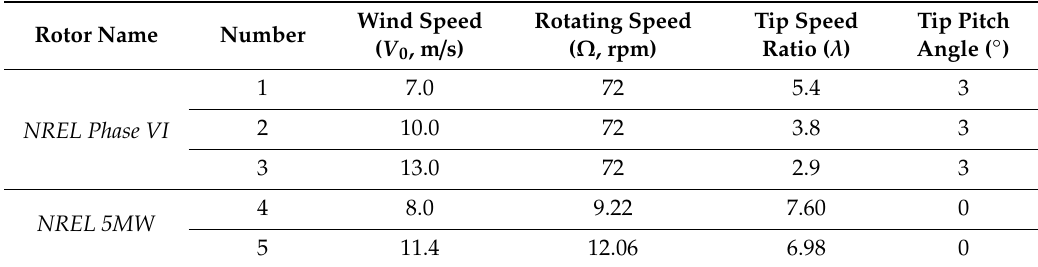
Table 1. Simulation cases for two di ff erent wind